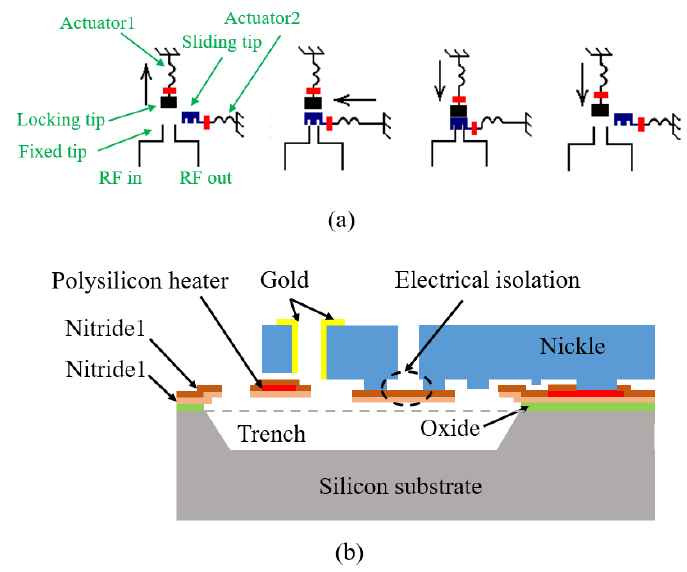
Figure 12. A latching MEMS electrothermal switch (BakriKassem M 2015 [41,42]): ( a ) the working principle; ( b ) the diagram of processing.